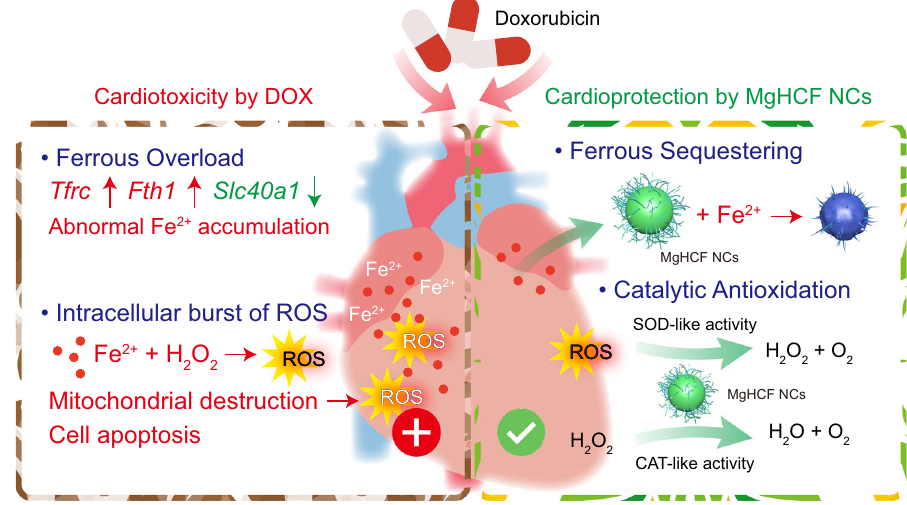
Fig. 1 | Scheme of cardioprotective strategy by MgHCF NCs. Schematic cardiotoxicity generation during chemotherapy using doxorubicin as well as herein proposed cardioprotective strategy by the synthetic MgHCF